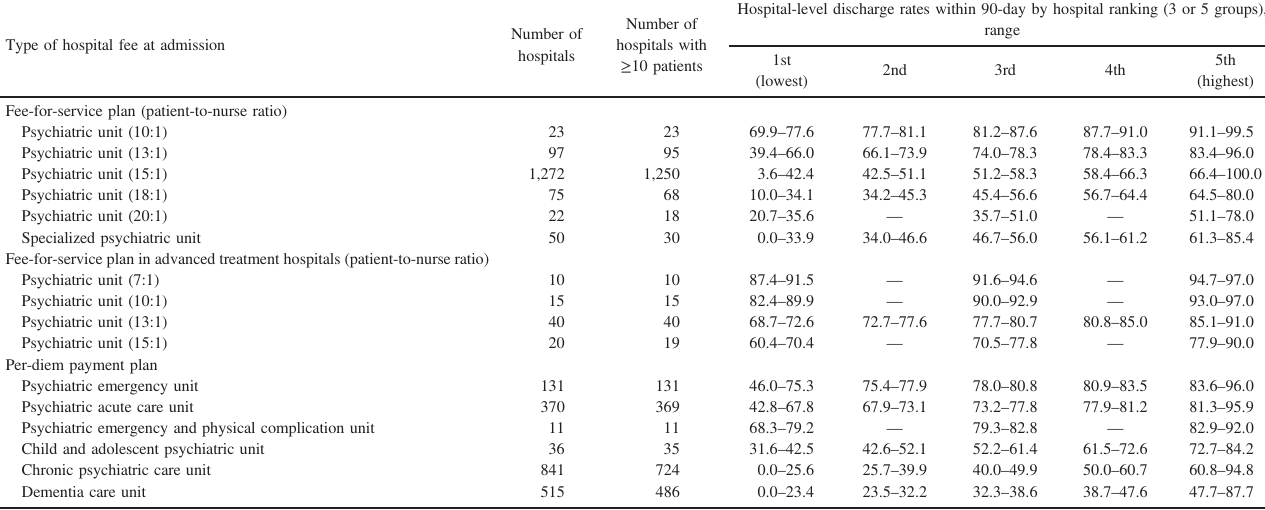
Table 3. Hospital-level discharge rates within 90 days from admissions by type of hospital fee